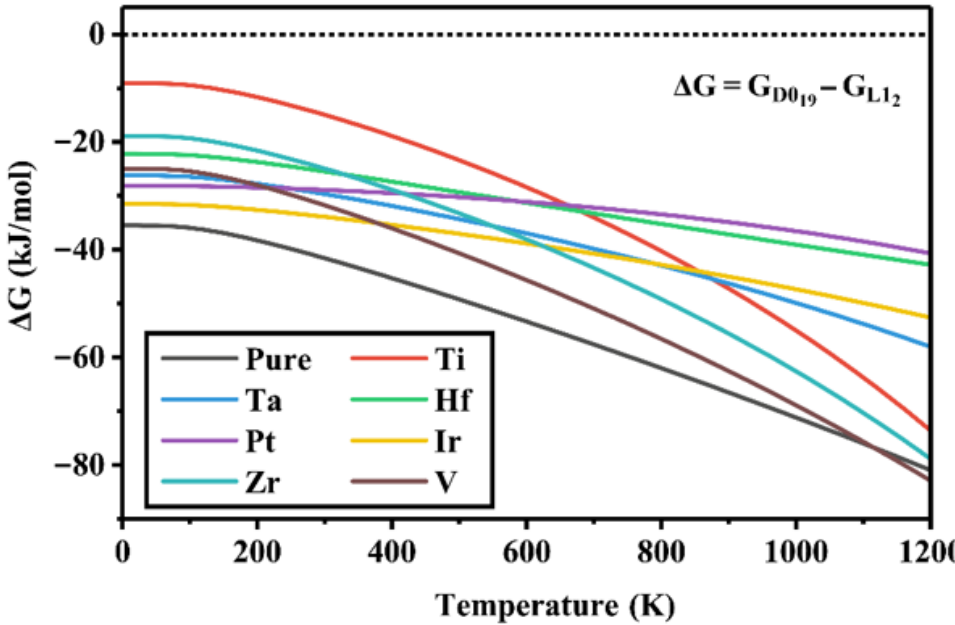
Figure 9. Calculated ∆ G of X-substituted Co 3 Nb compounds (X = Ti, Ta, Hf, Pt, Ir, Zr,